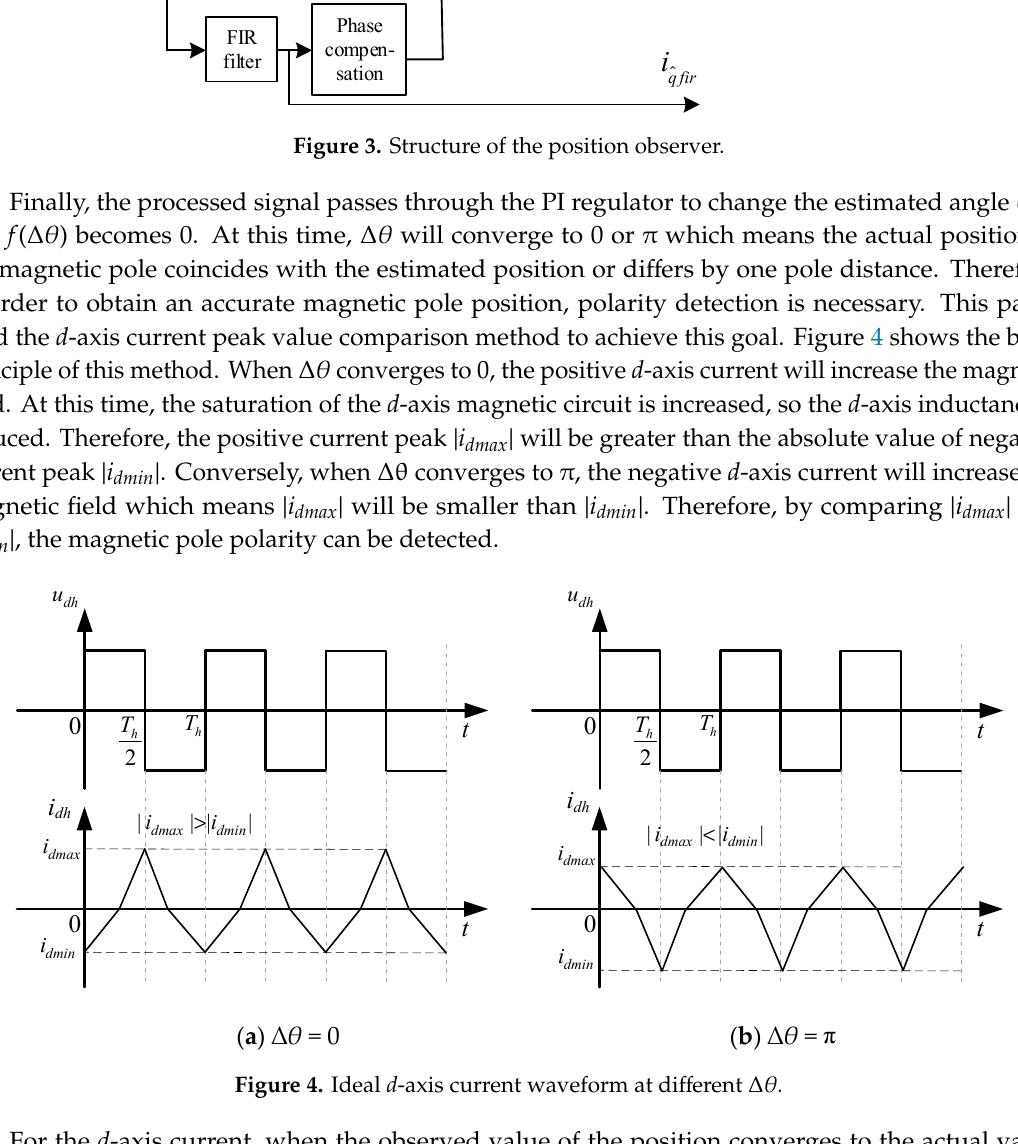
Figure 3. Structure of the position observer.